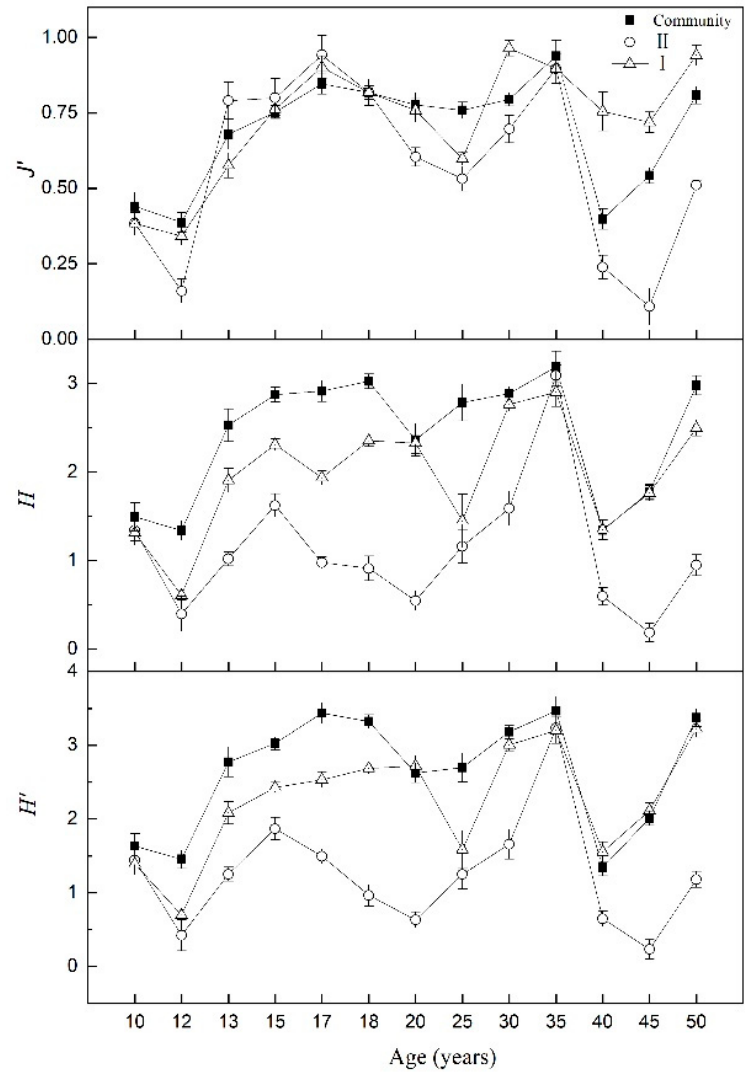
Figure 4. Diversity indices for the overall community, layer I, and layer II for the various forest ages. Table 1. Mean ( ± SD) soil organic C, total N, total P, and moisture contents in the R. pseudoacacia plantations.